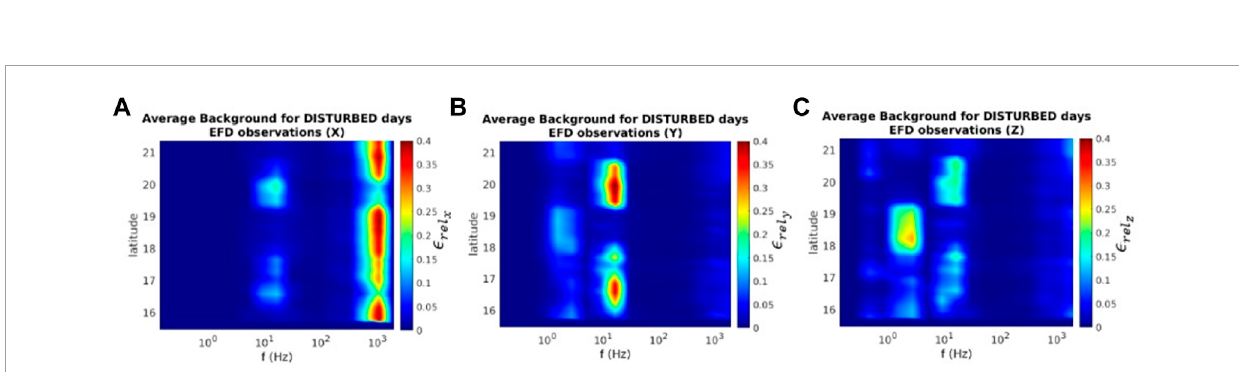
FIGURE 4 Average environmental background for disturbed conditions expressed as ϵ rel intensity vs. latitude (depending on time) and frequency for the three components of the electric field. ϵ rel values are generally larger than in the quiet case, but EM activity covers the same frequency